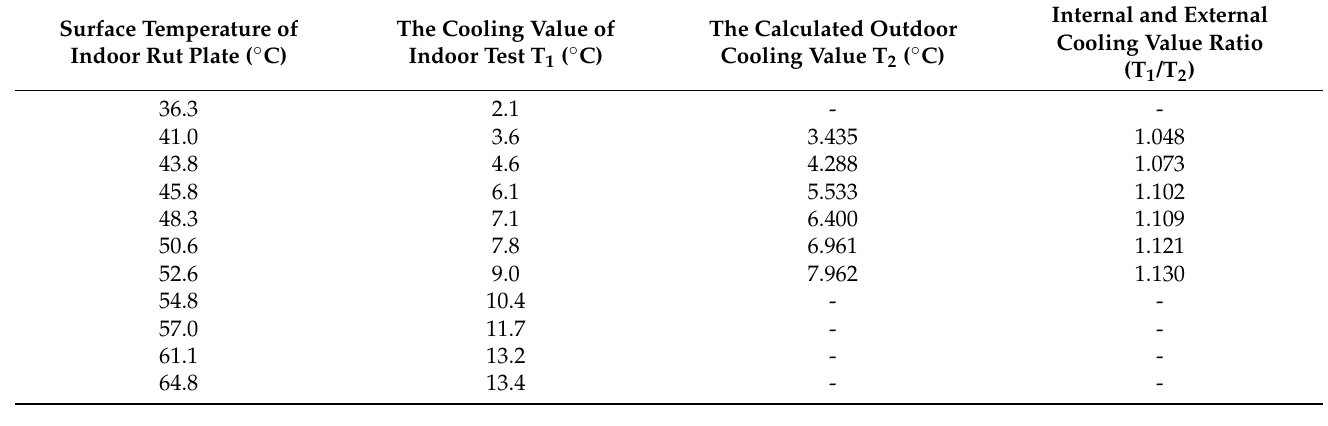
Table 8. Indoor and outdoor cooling value ratio at the same temperature.